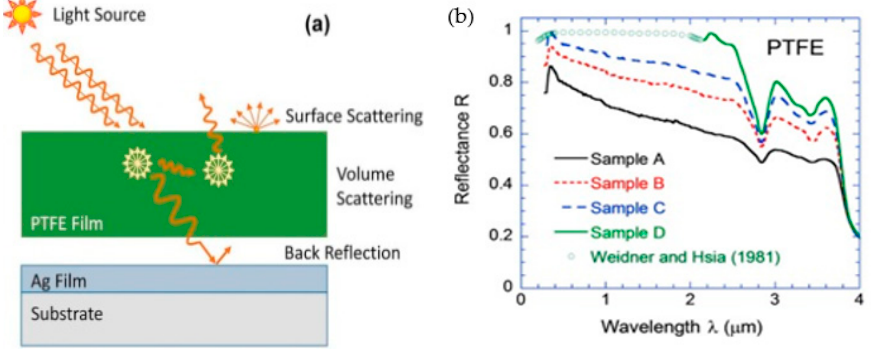
Figure 22. ( a ) PTFE sheet and a back reflector made of the Ag film [130] and ( b ) reflectance of the PTFE sheet for DPRC [130].